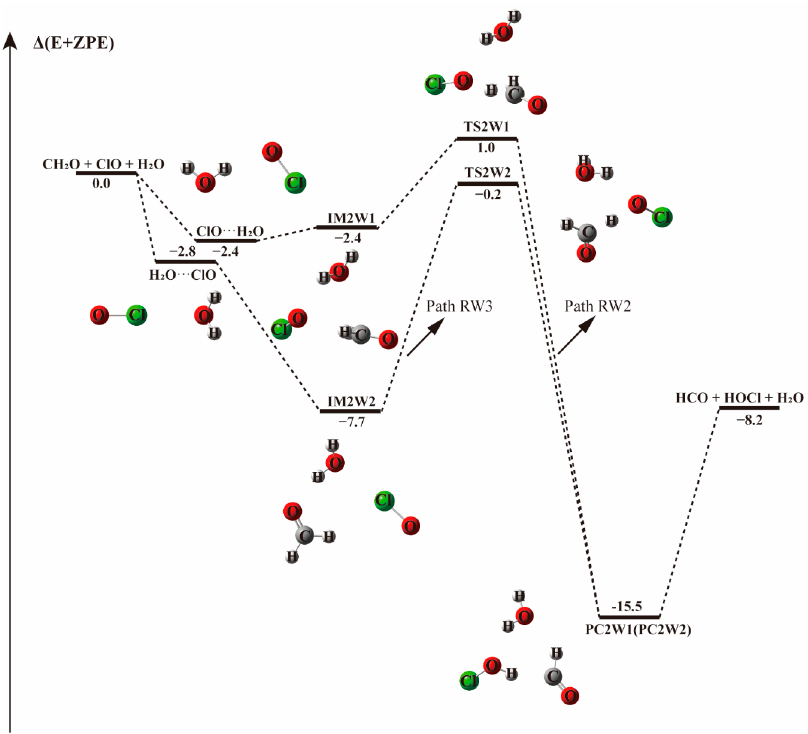
Figure 5. The energy profile of the CH 2 O + ClO water-assisted reaction occurring through ClO···H 2 O + CH 2 O pathway. Energies (in kcal mol − 1 ) are calculated at the CCSD(T)/aug-cc-pVTZ//B3LYP- D3/aug-cc-pVTZ level. Table 3. Electronic energies ( Δ E and Δ (E + ZPE)), enthalpies [ Δ H(298 K)], and Gibbs free energies [ Δ G(298 K)] for the reaction with a single water molecule occurring through CH 2 O···H 2 O + ClO and Table 4. Electronic energies ( ∆ E and ∆ (E + ZPE)), enthalpies [ ∆ H(298 K)], and Gibbs free energies [ ∆ G(298 K)] for the reaction occurring through CH 2 O ··· (H 2 O) 2 + ClO and ClO ··· (H 2 O) 2 + CH 2 O. The units of the energies are kcal mol − 1